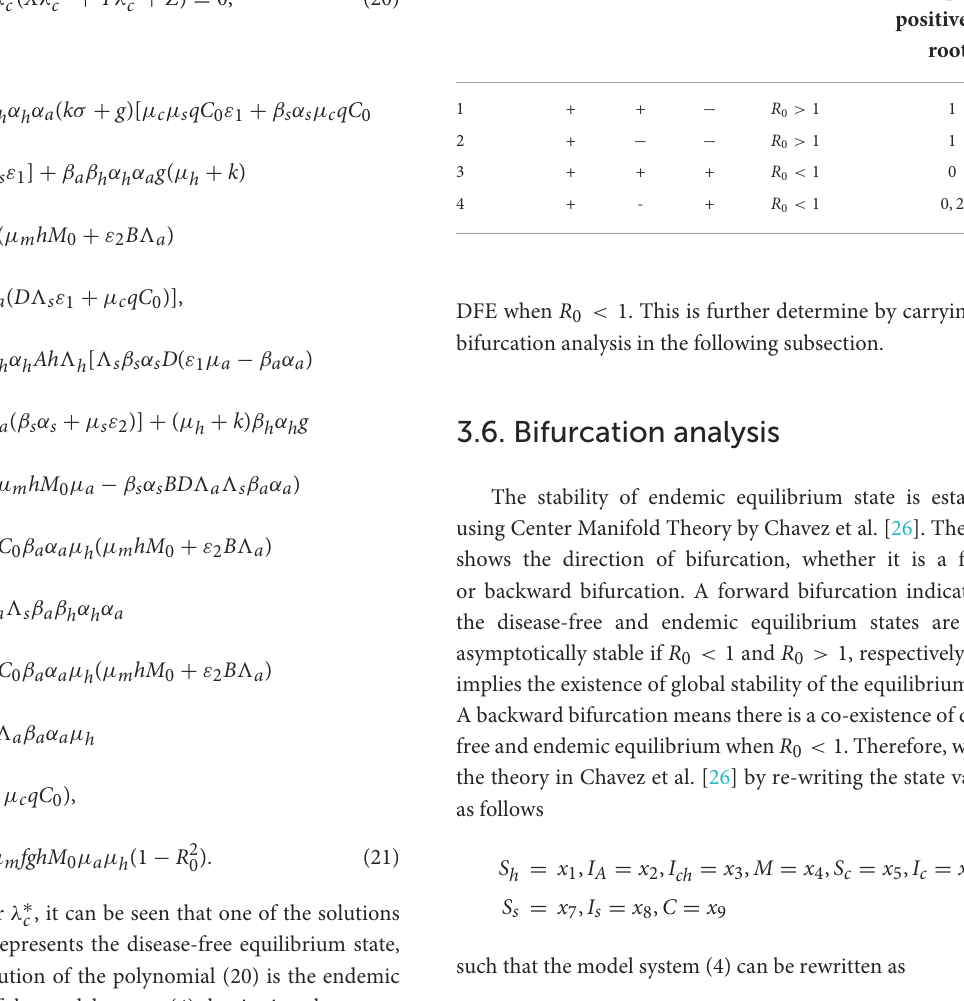
TABLE 1 No. of possible positive real roots for (20).